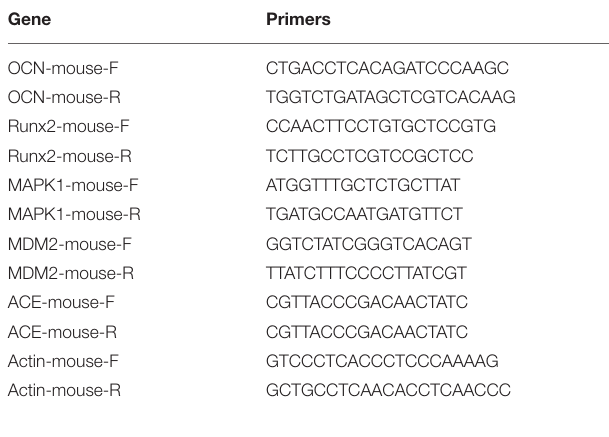
TABLE 2 | Primer sequences.